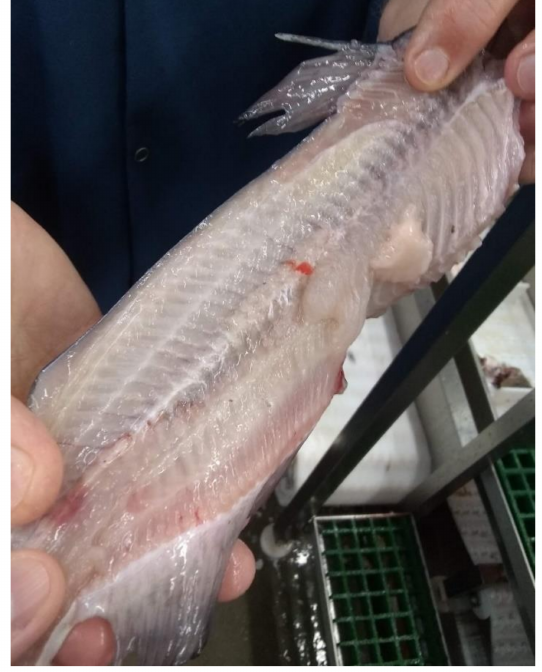
Figure 5. A fish rib bone from the filleting machine has a lot of fish meat left on it.